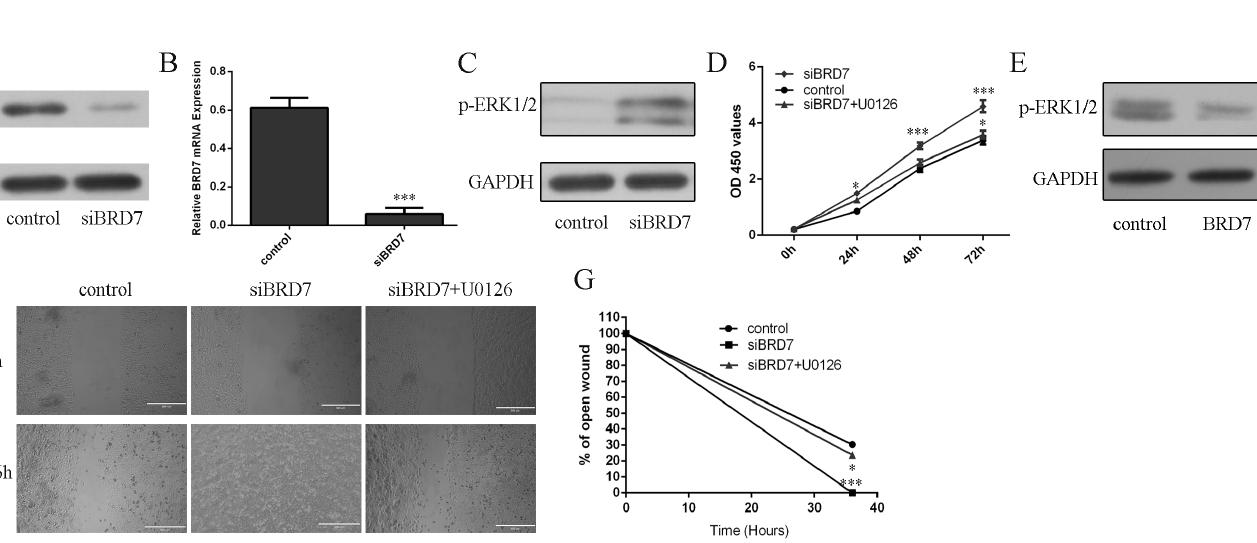
Fig 5. Inhibition of BRD7 promoted ERK phosphorylation in lung adenocarcinoma. (A) The protein expression level of BRD7 was measured by using Western blot. (B) The mRNA expression level of BRD7 was measured by using qRT-PCR. (C) Inhibition of BRD7 promoted the ERK phosphorylation in the A549 cells. (D) CCK8 analysis was used to measure the A549 cell proliferation. (E) Overexpression of BRD7 suppressed the ERK phosphorylation in the A549 cells. (F) Wound-healing assay was performed to measure the A549 cell migration. (G) Relative ratio of wound closure per field is shown. * p < 0.05 and *** p <